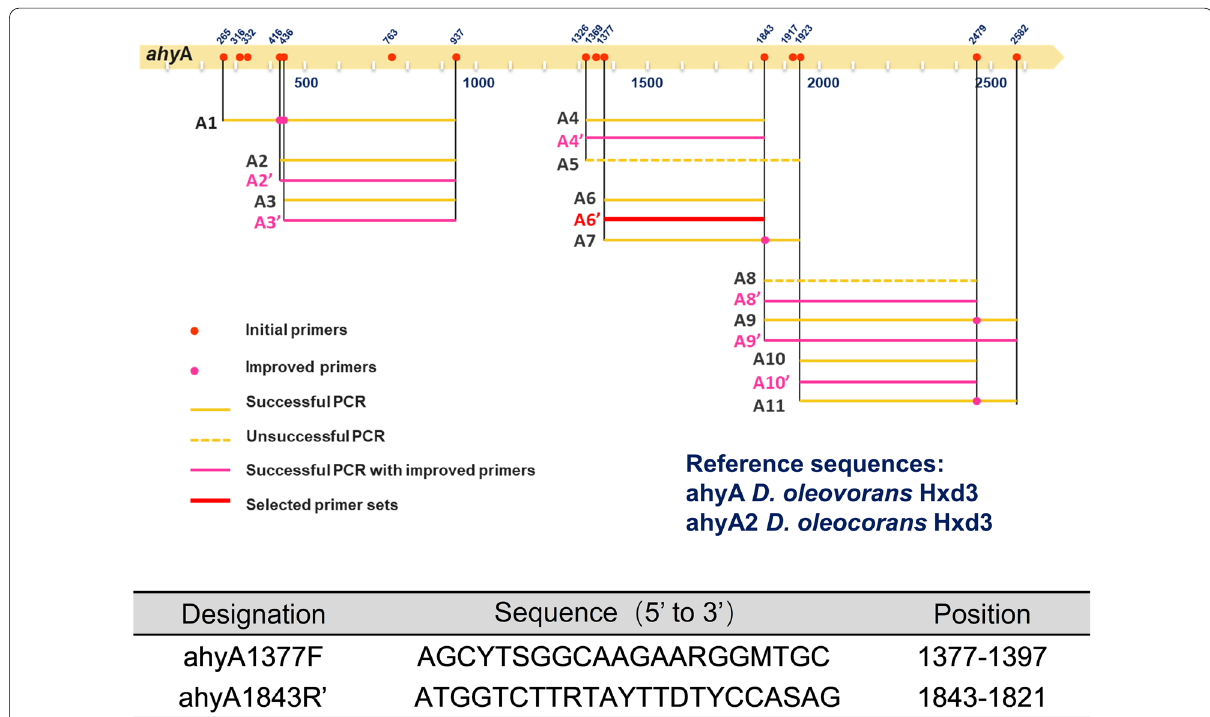
Fig. 1 Location of the primers designed in this study with reference to ahy genes of D. oleovorans . The positioning of ahy primers refers to the Desulfococcus oleovorans strain Hxd3 ahy gene (WP_012173623.1). Initial primers are shown in red and improved primers are shown in pink. After being tested, primers ahyA1377F and ahyA1843R’ shown in red were selected for subsequent